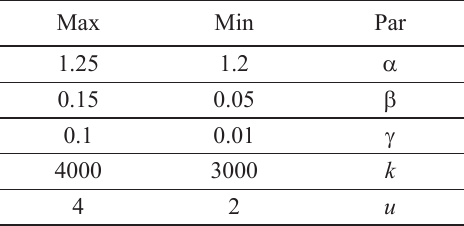
Table 5. Key parameters for sensitivity analysis